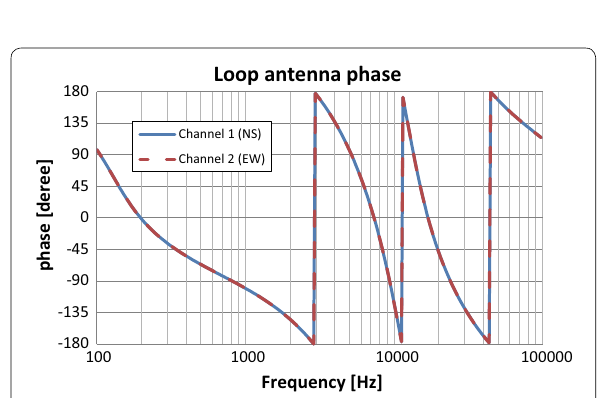
Fig. 13 Frequency dependence of phase of the loop antenna to measure the ELF/VLF radio